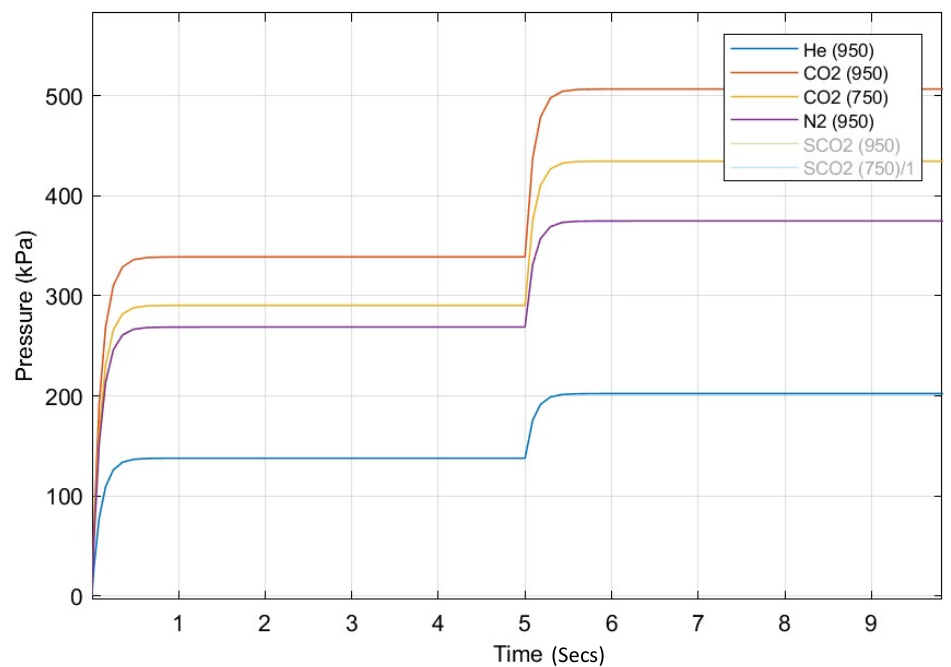
Figure 6. Control-valve response times (secs), with dynamic response and stability of pressures (kPa) for the various working fluids. Note : SCO 2 pressures are much higher and are in Figure 7.